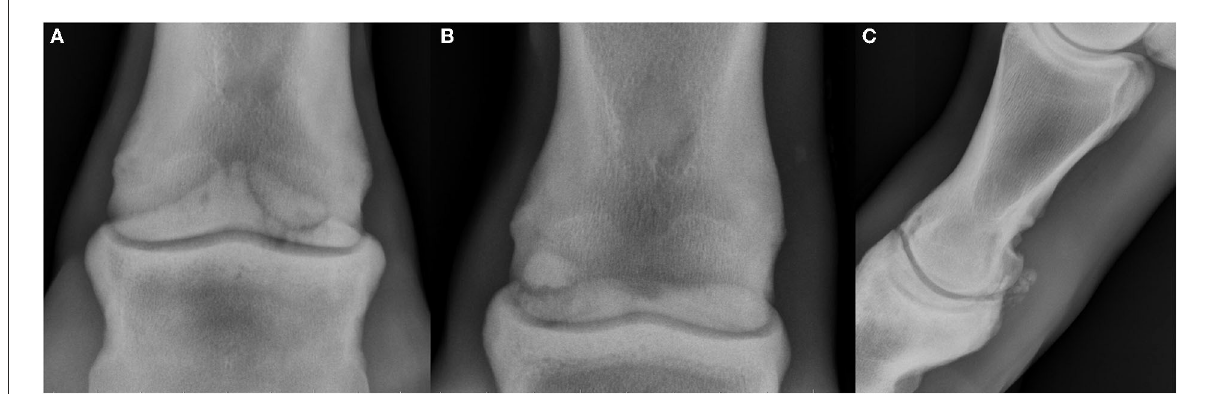
FIGURE3 Radiographs showing osteochondral fragmentation of the proximal interphalangeal joint (PIPJ), dorsal and lateral are oriented at the left of the images. (A) Dorsopalmar projection showing a large enthesophyte on the proximopalmar aspect of the middle phalanx with large well-defined osteochondral fragment at the palmaromedial aspect. (B) Dorsoplantar projection showing a well-defined, smoothly marginated osteochondral fragment at the palmaroproximolateral aspect of the middle phalanx adjacent to a concave defect in the parent bone. (C) Lateromedial projection showing numerous poorly marginated osseous fragments at the plantar aspect of the PIPJ with periarticular remodeling which is most severe